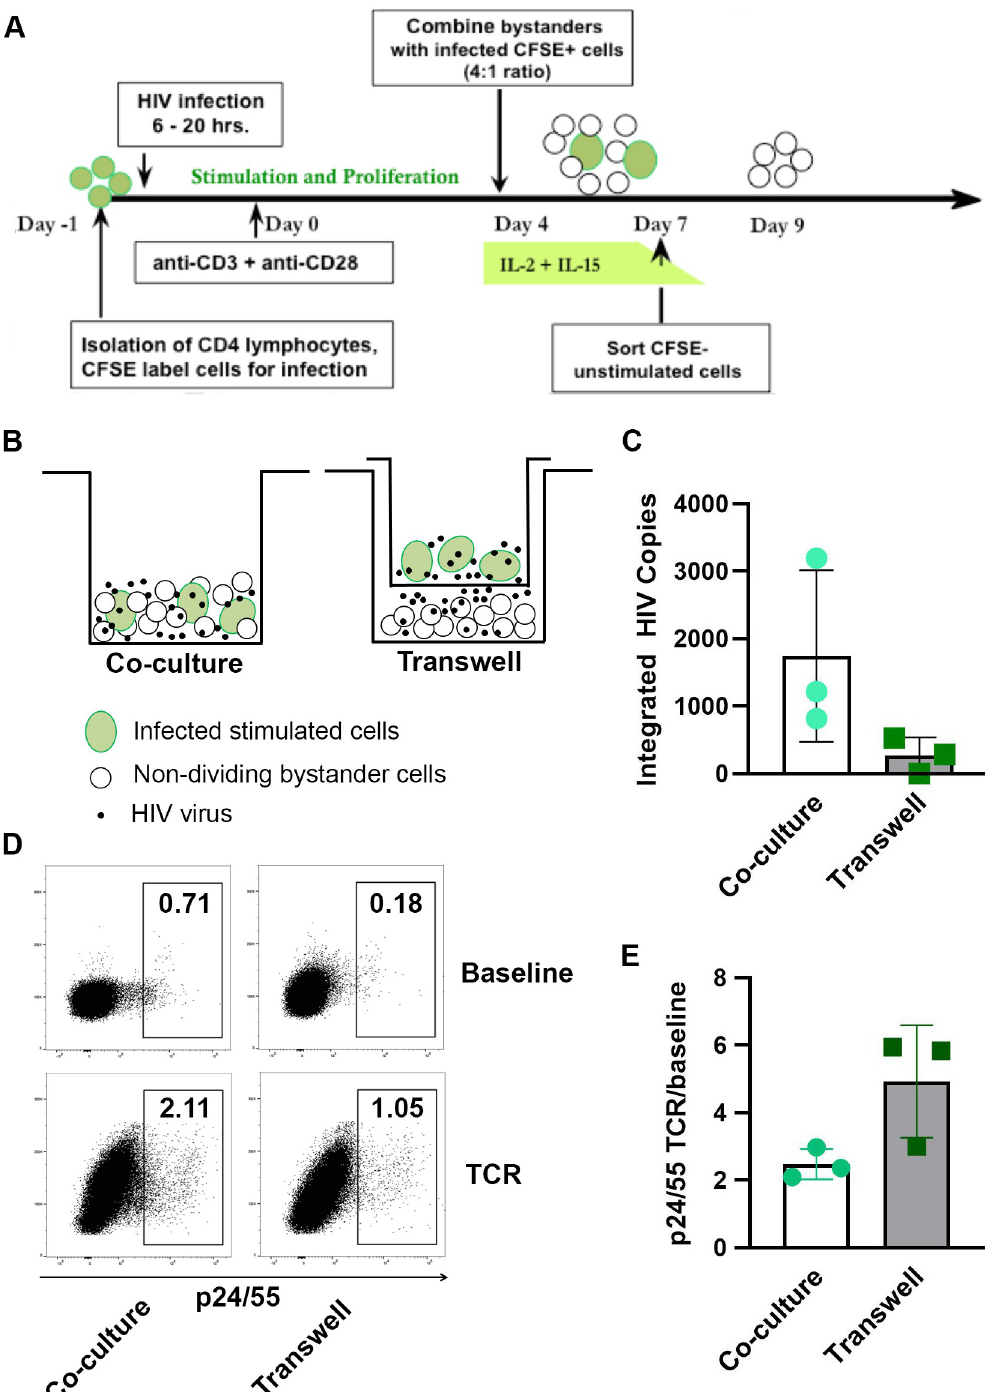
Fig 8. Optimized model of bystander cell infection and the importance of cell-to-cell contact. (A) Diagram of the optimized in vitro bystander cell model to generate latently infected primary CD4 T cells. A portion of isolated primary CD4 T lymphocytes were labeled with CFSE dye, held overnight, washed, and then acutely infected (6–20 hr) with NL4-3. Following infection, the cells were cultured in flat-bottom plates with immobilized anti-CD3 + anti-CD28 antibodies to stimulate cell proliferation and virus replication. Four days following activation, the infected CSFE-labeled cells were removed from the TCR stimulus and mixed with unstimulated, uninfected autologous CD4 T cells (unlabeled); and the cell mixture, cultured in fresh medium containing exogenous rIL-2 and rIL-15 for 3 days. On day 7 of culture, the